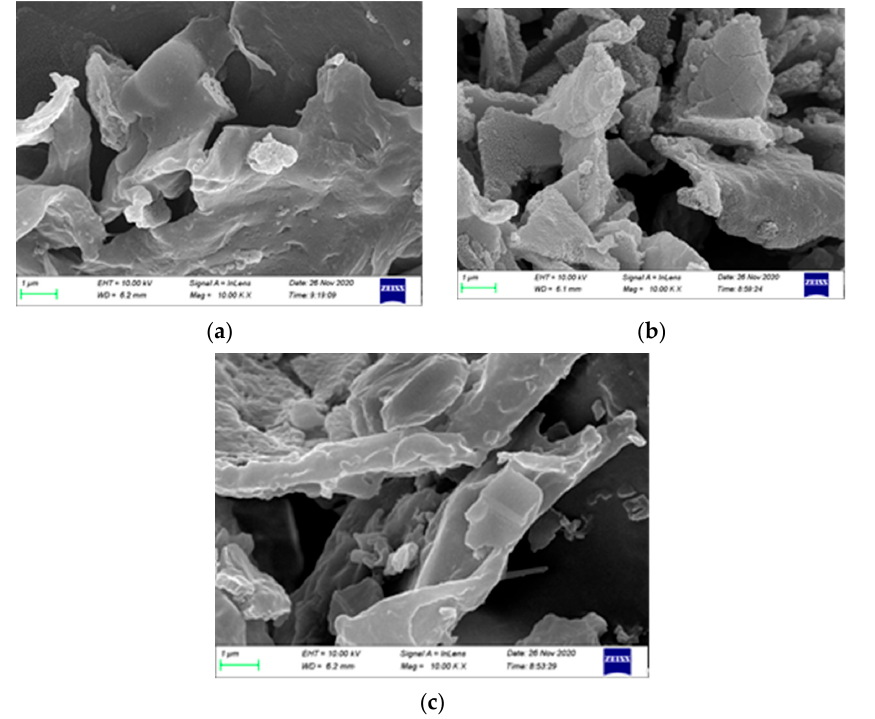
Figure 6. SEM images of activated carbon prepared using a 5% concentration of steam activation of raw materials with different mixing ratios: ( a ) B:F = 1:0, ( b ) B:F = 5:1 and ( c ) B:F = 2:1.